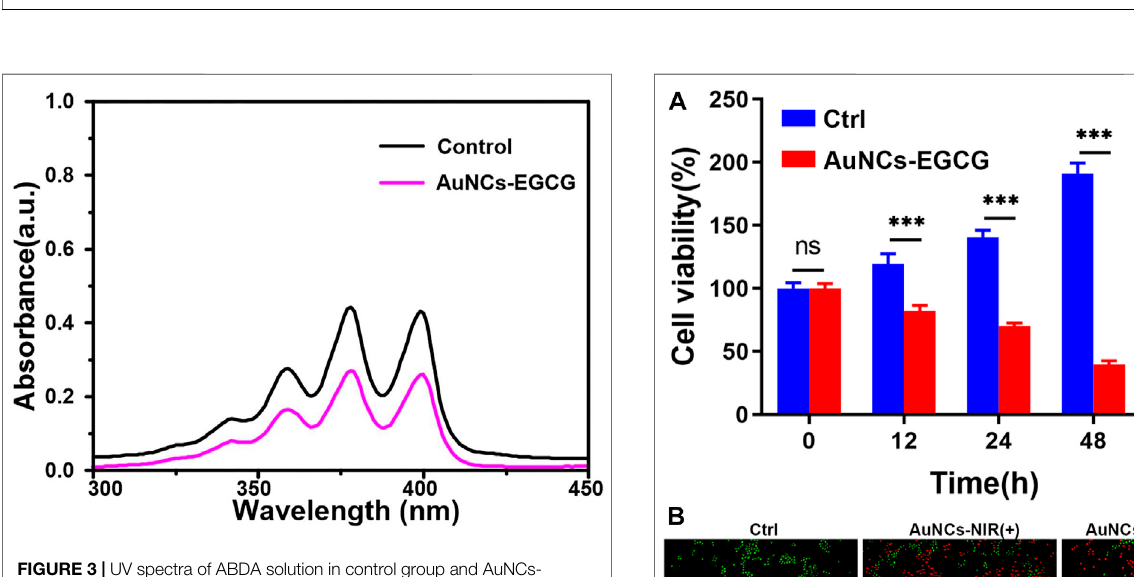
FIGURE 2 | Drug release from AuNCs-EGCG. (A) The release of EGCG from AuNCs-EGCG with or without laser irradiation. (B) The drug release curve of AuNCs- EGCG.